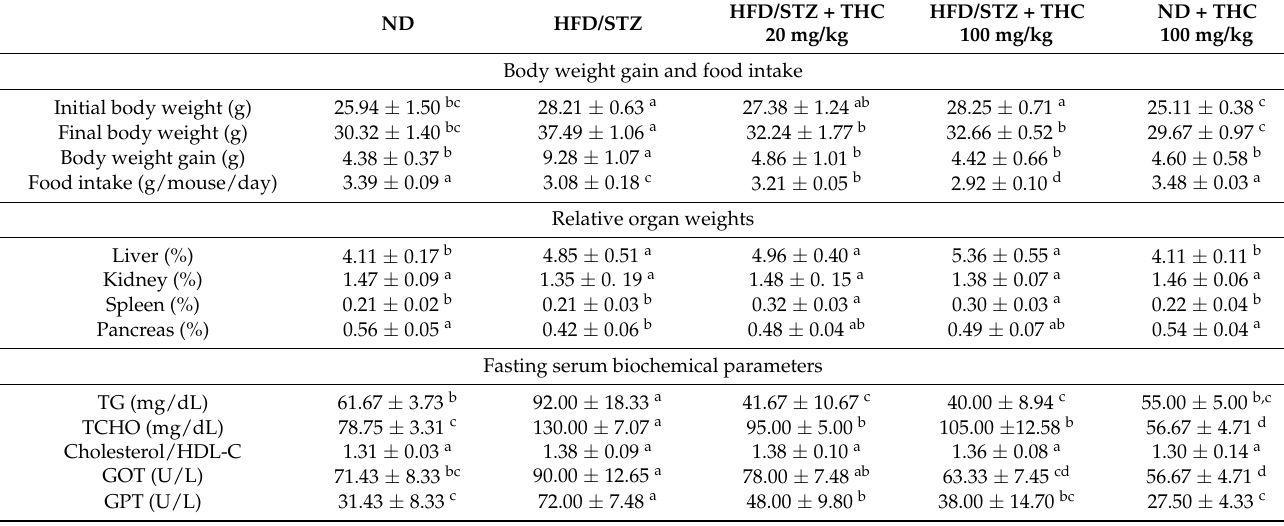
Table 1. Effect of THC on body weight, food intake, relative organ weights and serum parameters in HFD/STZ model C57BL/6J